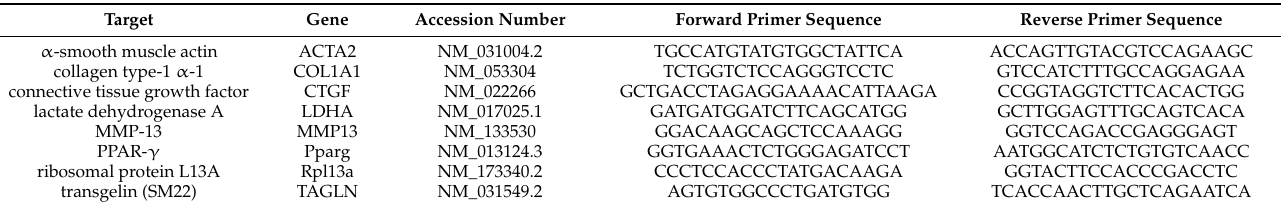
Table 1. PCR Primer